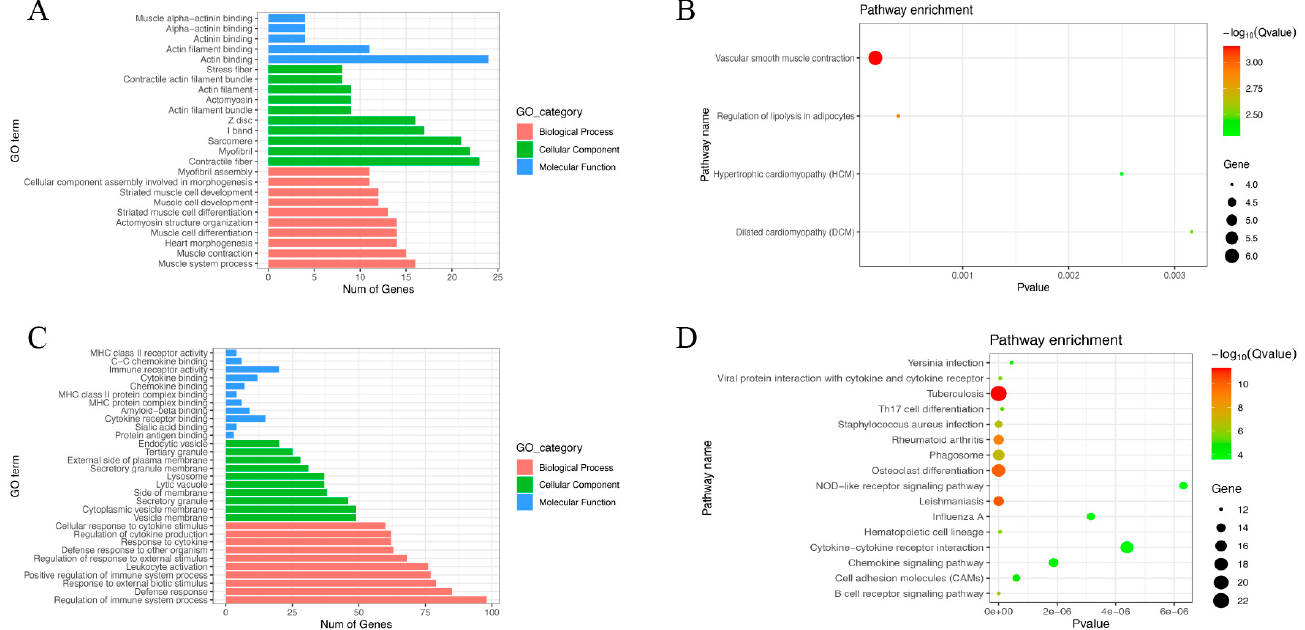
Figure 9. GO and KEGG enrichment analysis of hyper-down genes and hypo-up genes in AS. ( A ) GO term annotation analysis of hyper-down genes. ( B ) KEGG pathway analysis of hyper-down genes. ( C ) GO term enrichment analysis of hypo-up genes. ( D ) KEGG pathway analysis of hypo-up genes.